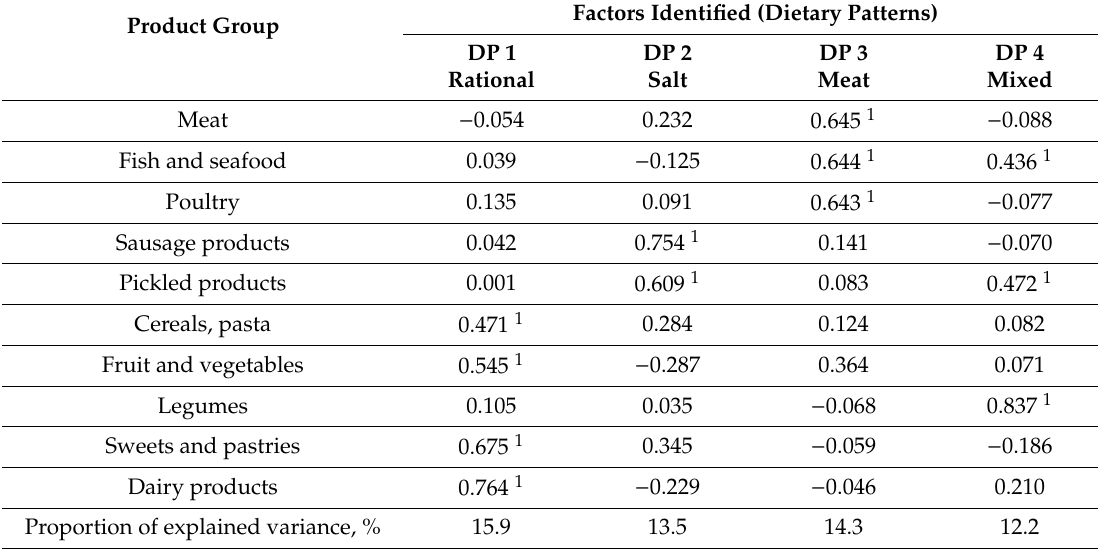
Table 2. Factor loadings of the principal dietary patterns